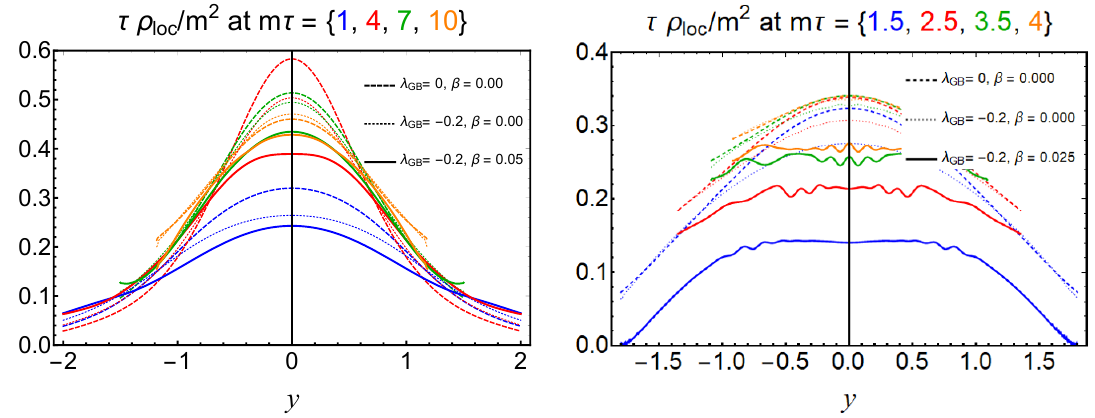
Figure 8 . The baryon number density in the local (cid:13)uid rest frame, multiplied by the proper time (cid:28) , as a function of the spacetime rapidity y plotted at several di(cid:11)erent proper times after the collision of thick sheets (left) and thin sheets (right). The presence of the (cid:21) corrections makes the GB rapidity distribution of the baryon number wider and lower, with more baryon number at higher rapidity. The e(cid:11)ect of (cid:12) is similar, but much stronger. Note also that at mid-rapidity the product (cid:28)(cid:26) loc is approximately constant at late times, as would be expected if the dynamics approaches boost-invariance at late times. The wiggles in the results from our (cid:12) = 0 : 025 calculations plotted in the right panel are artifacts of our numerical discretization; as we go to (cid:12)ner discretizations, the wiggles decrease while in other respects the results do not